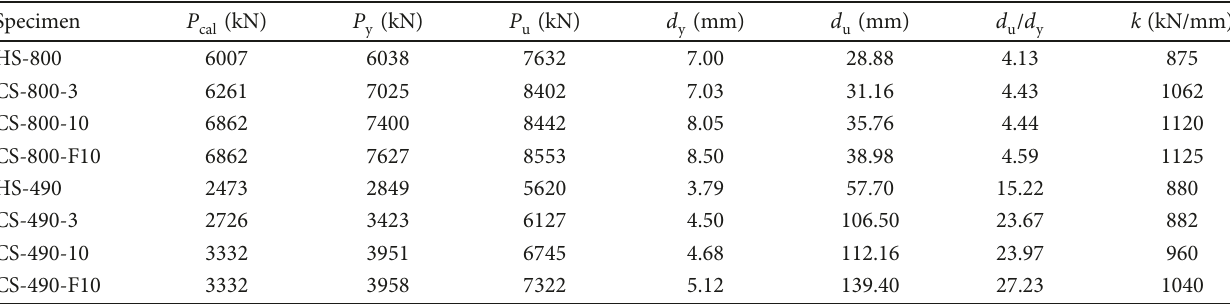
Table 5: Strength of test specimens.